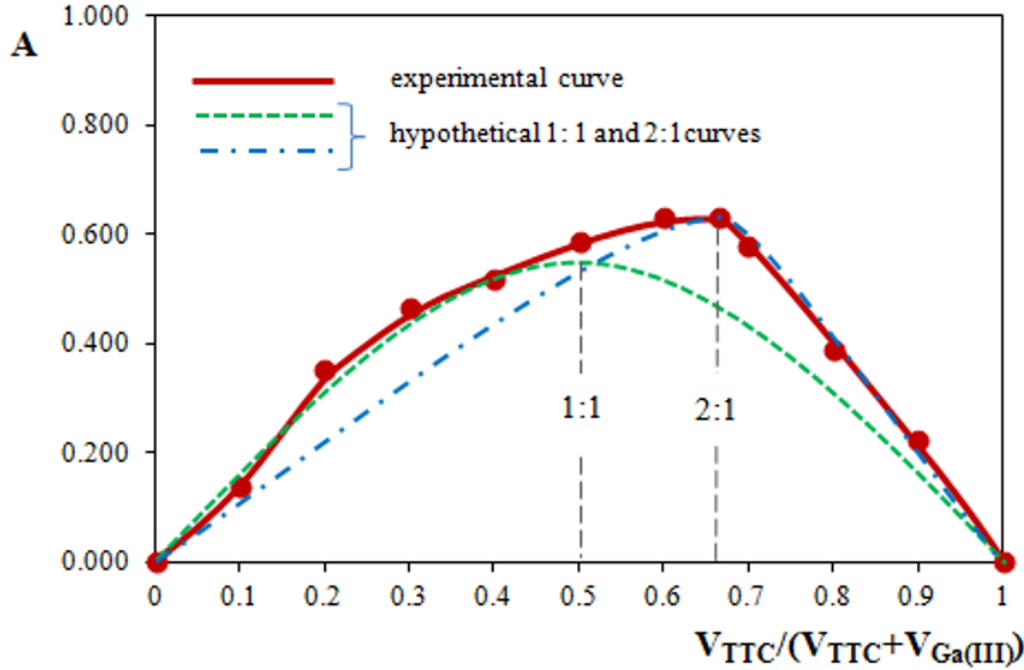
Figure 4. Determination of the TTC-to-Ga(III) molar ratio in the Ga(III)-TAR-TTC system by the method of continuous variations. pH=6.7, C